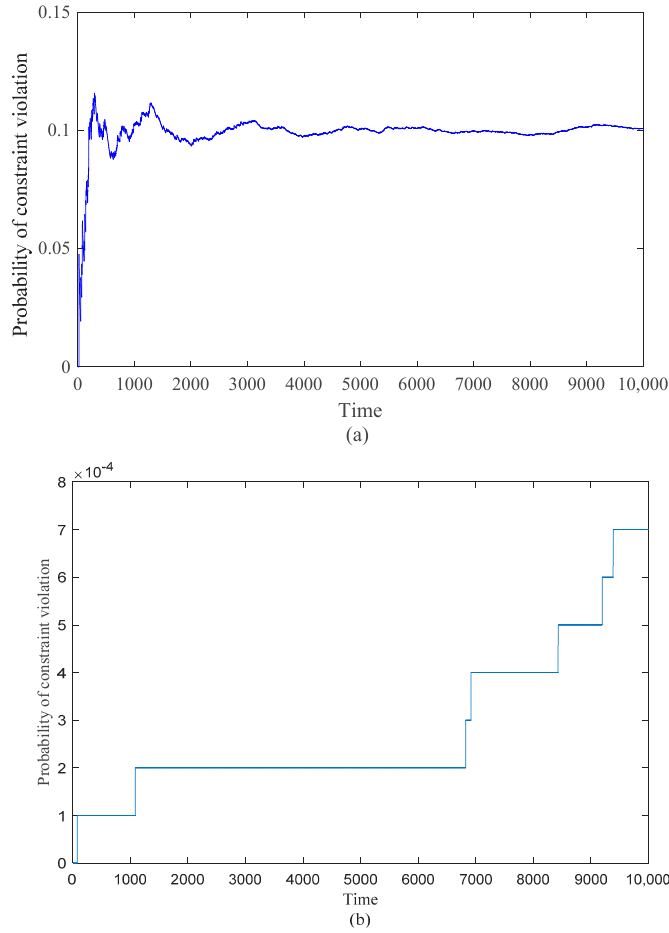
Figure 3. Comparison on constraint violation probabilities. ( a ) The proposed method; and ( b ) Robust MPC via scenarios optimization.